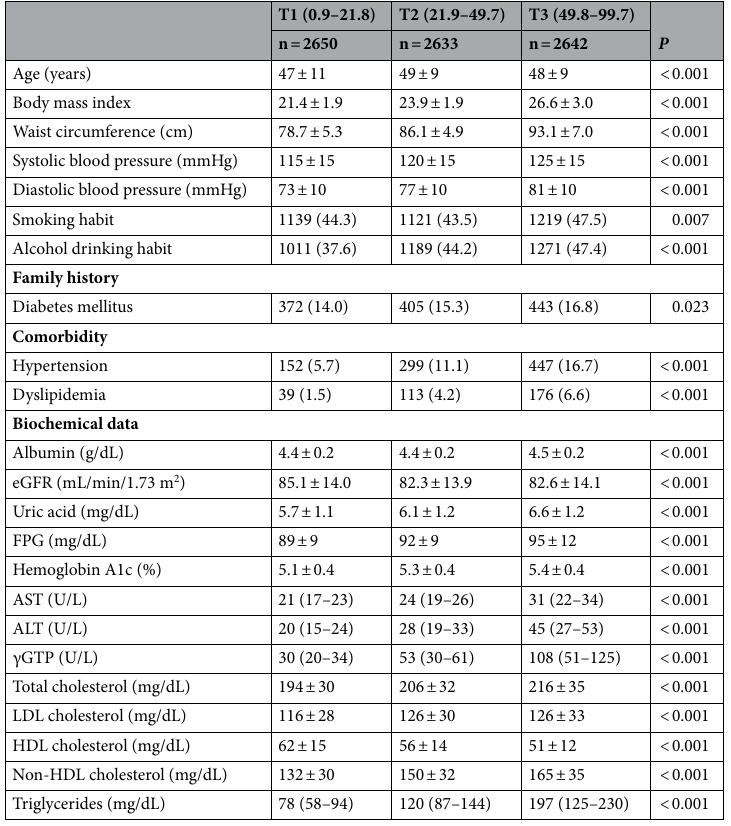
Table 2. Characteristics of male subjects divided by tertiles of FLI at baseline (n = 7925). Variables are expressed as number (%), means ± SD or medians (interquartile ranges). AST aspartate aminotransferase, ALT alanine aminotransferase, eGFR estimated glomerular filtration rate, FLI fatty liver index, FPG fasting plasma glucose, γGTP γ-glutamyl transferase, HDL high-density lipoprotein, LDL low-density